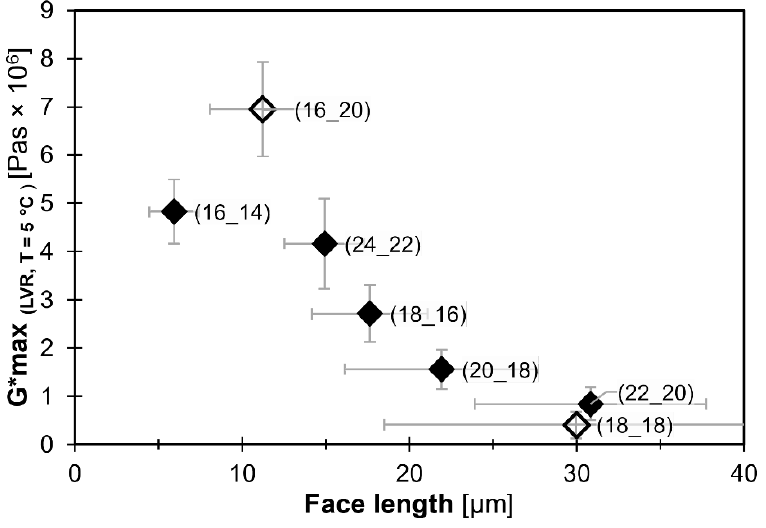
Figure 9. Respective level of G ∗ max (within LVR; T = 5 ◦ C) as function of L face for mono-ester gels (10% [ m / m ] WE in MCT oil). Cooling rate: 5 K/min. Filled diamonds: homologous series of ∆ CN = + 2, hollow diamonds: not part of homologous series. All WE are denoted as (FaOH_FA).